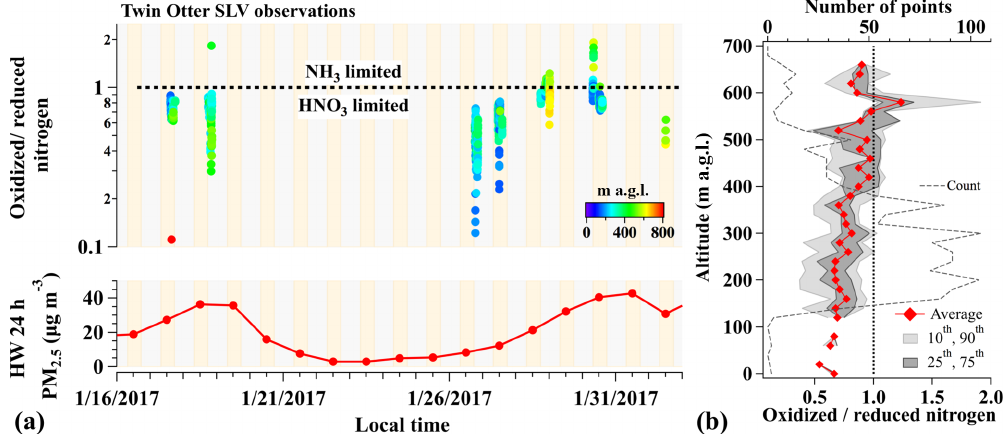
Figure 5. ( a , top) Time series of the ratio of total oxidized (HNO 3 + NO − ) to reduced (NH 3 + NH + ) nitrogen between 16 January and 3 4 1 February 2017 (10s averages), calculated from TO observations over the SLV. Individual nitrogen ratios are colored by aircraft altitude (ma.g.l.). Yellow and gray shading indicate times of day and night, respectively. ( a , bottom) PM 2 . 5 mass (24h average) measured at the HW ground site. (b) Vertical profile of oxidized-to-reduced nitrogen ratios from panel (a) . Diamonds represent the average values in each altitude bin and gray shading shows the 10th–90th (light gray) and 25th–75th (dark gray) percentiles. The number of points in each bin is shown by the gray dashed line. The vertical black line illustrates a nitrogen ratio of